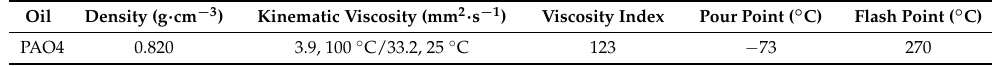
Figure 1. High-resolution transmission electron microscopy (HR-TEM) ( a , b ) and AFM images of diesel soot ( c ). Table 1. Typical physicochemical properties of PAO4 oil.